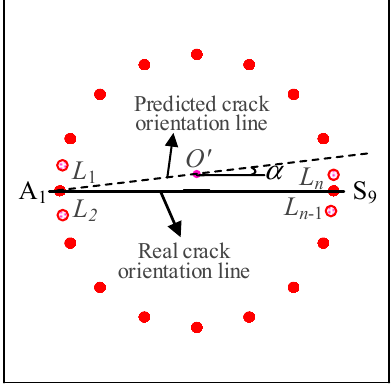
Figure 9. Determination of the crack orientation.